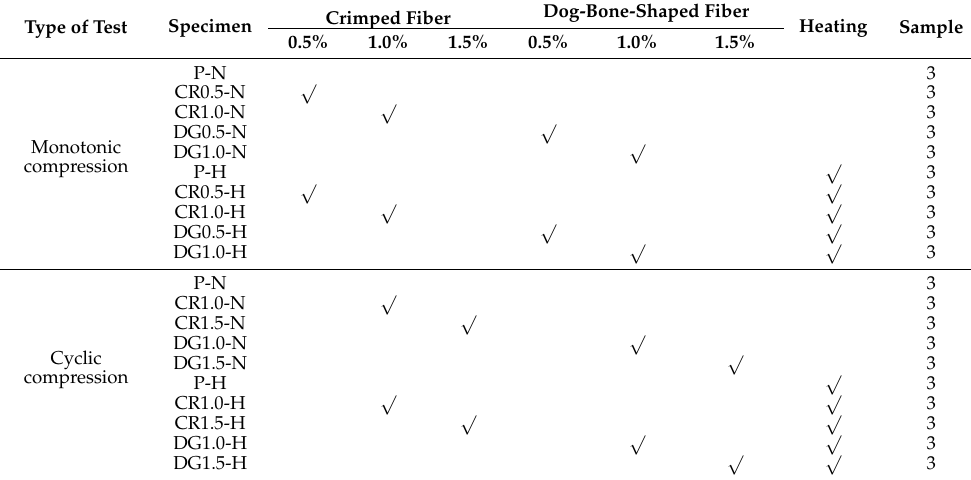
Table 2. Matrix of mortar reinforced fiber